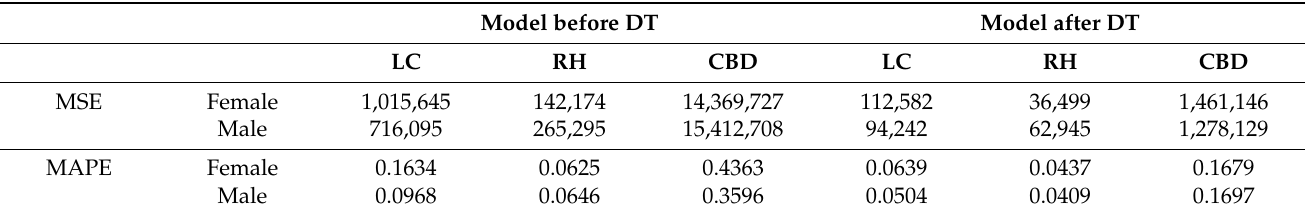
Table 2. Performance of three models before and after the